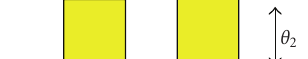
Figure 9: Simulation and measurement results of the proposed stepped impedance bandstop filter.